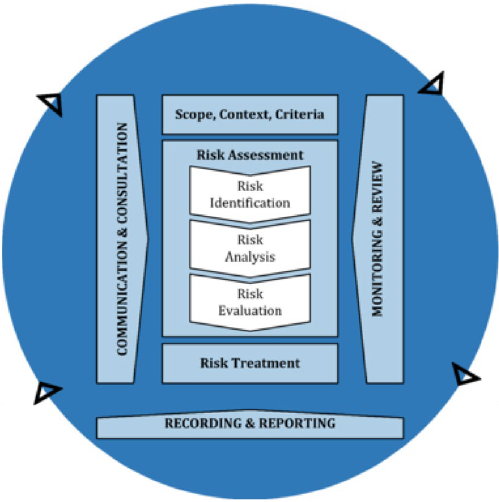
Figure 1. Risk management process 12